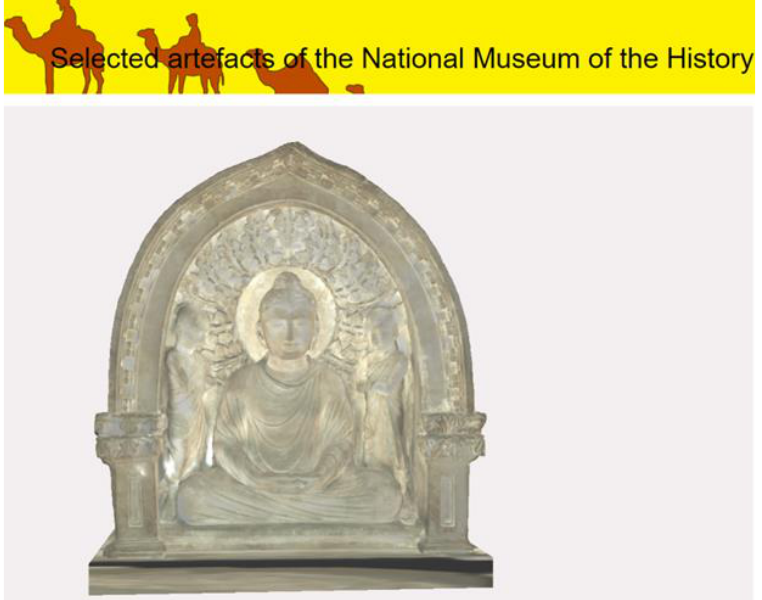
Figure 13. 3D dissemination model of the “Buddha” statue [40].